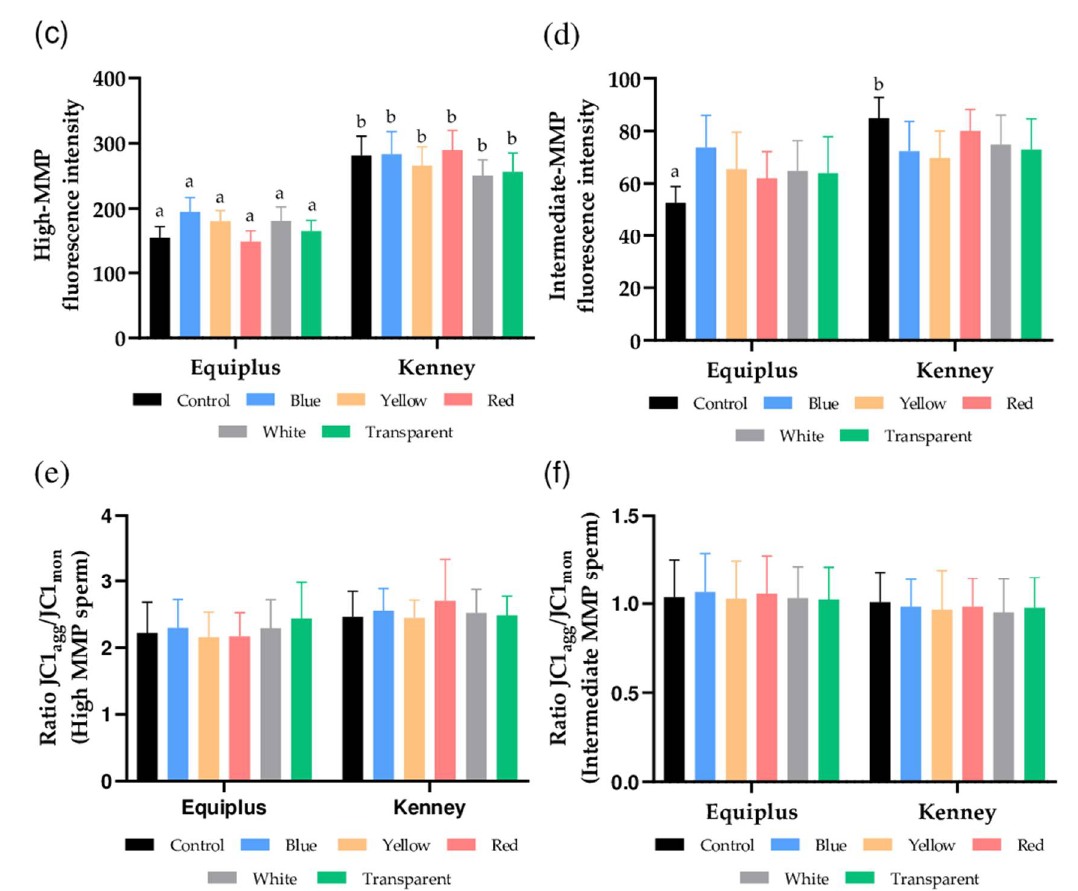
Figure 2. Effects of the color of the straw, extender, and light stimulation on mitochondrial membrane potential in control (nonirradiated) and irradiated samples packed into straws of different color and extended either with Equiplus or Kenney extender. The results are presented as percentages of sperm with high mitochondrial membrane potential (MMP; a ) and with intermediate mitochondrial membrane potential (MMP; b ), geometric mean of fluorescence intensity of JC1 agg (GMFI, FL2) in sperm populations with high ( c ) and intermediate MMP ( d ), and JC1 agg /JC1 mon ratios (GMFI FL2/GMFI FL1) in sperm populations with high ( e ) and intermediate MMP ( f ) in nonirradiated (control) and irradiated samples. Different numbers (1, 2) indicate significant differences ( p < 0.05) between nonirradiated and irradiated samples packed into straws of different color within the same diluent. Different letters (a, b) indicate significant differences ( p < 0.05) between the two extenders within nonirradiated or samples irradiated and packed into straws of different color. The absence of numbers indicates the lack of statistical differences between irradiated and nonirradiated samples within the same diluent, and the absence of letters indicates the lack of differences when comparing a given treatment between both diluents. Data are shown as mean ± SEM of 13 separate